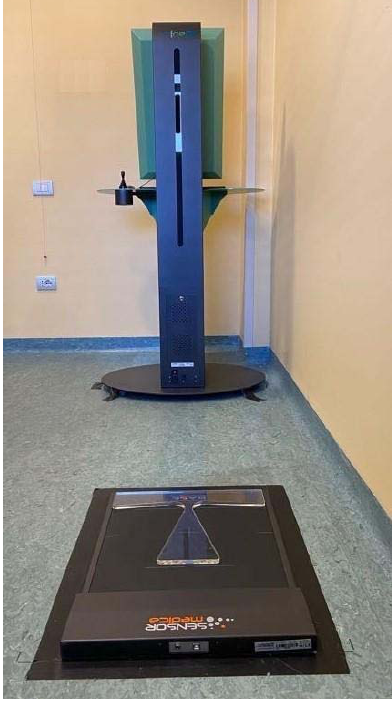
Figure 2. The clinical setting for the study protocol with the two instruments in the correct position for the acquisitions.